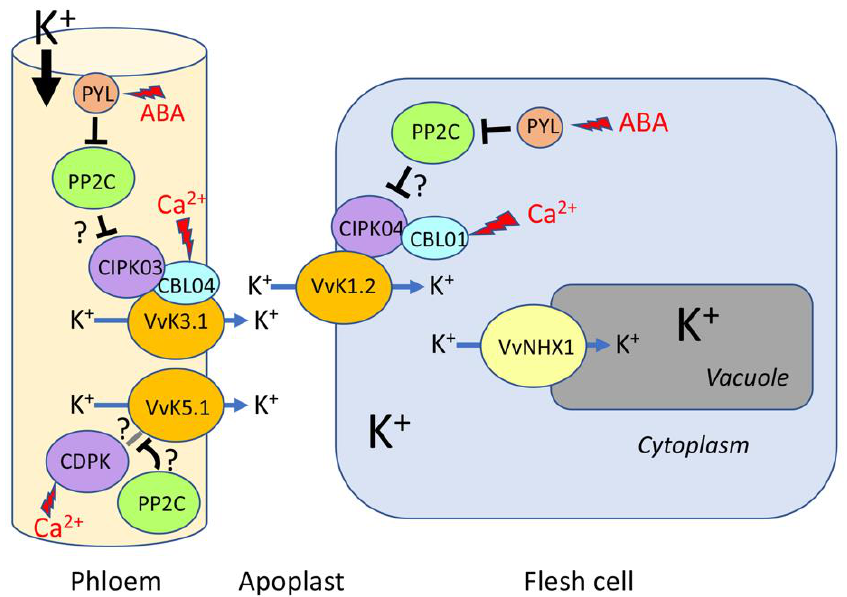
Figure 2. Schematic representation of known and expected K + transport pathways in grape berries after the onset of ripening. K + is delivered to berries via the phloem [15] and must cross the phloem plasma membrane barrier before accumulating in mesocarp cells [35]. This K + flux to the apoplastic space involves the Shaker VvK3.1 channel. The activity of this channel can be enhanced by CIPK/CBL couples, possibly via an unusual mechanism of CBL anchoring in the plasma membrane [33]. Moreover, the depolarization-activated VvK5.1 channel present in phloem cells could control the plasma membrane potential [103]. By analogy with its GORK counterpart, VvK5.1 is expected to be modulated by CPKs [17]. Once in the apoplast, K + is taken up by the flesh cells owing to the VvK1.2 Shaker channel [32], which recruits CIPK/CBL partners for its activation. CIPKs are also known to be inhibited by their interaction with PP2Cs of the ABA signaling pathway [17]. PP2Cs are, in an ABA-dependent manner, under the negative control of PYR/PYL/RCAR receptors. The VvNHX1 H + /K + exchanger mediates K + transfer to the vacuole, where this ion is accumulated [114].